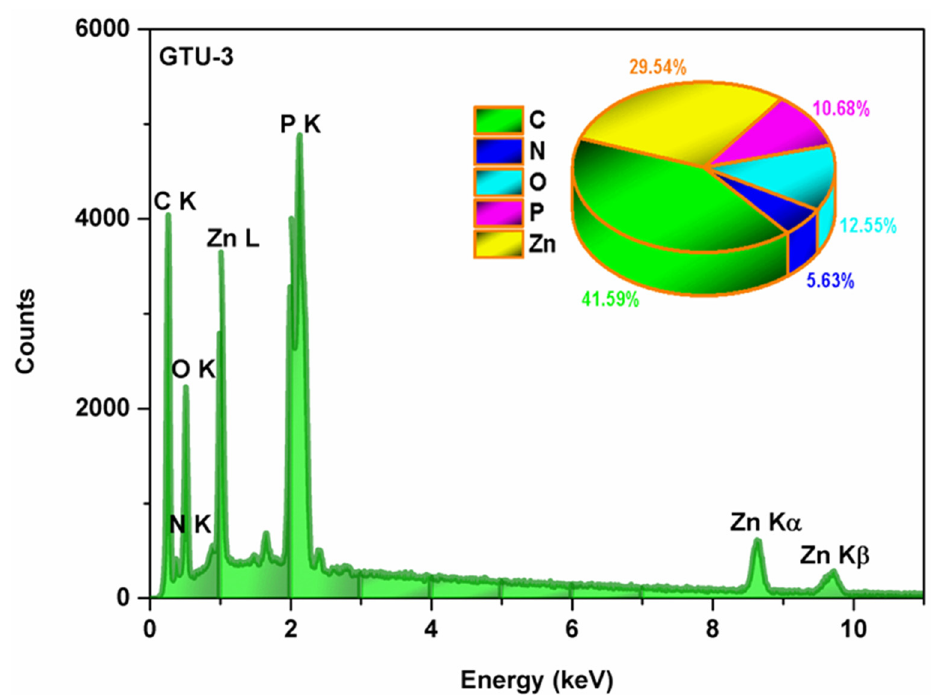
Figure 3. EDX spectra of the GTU-3.